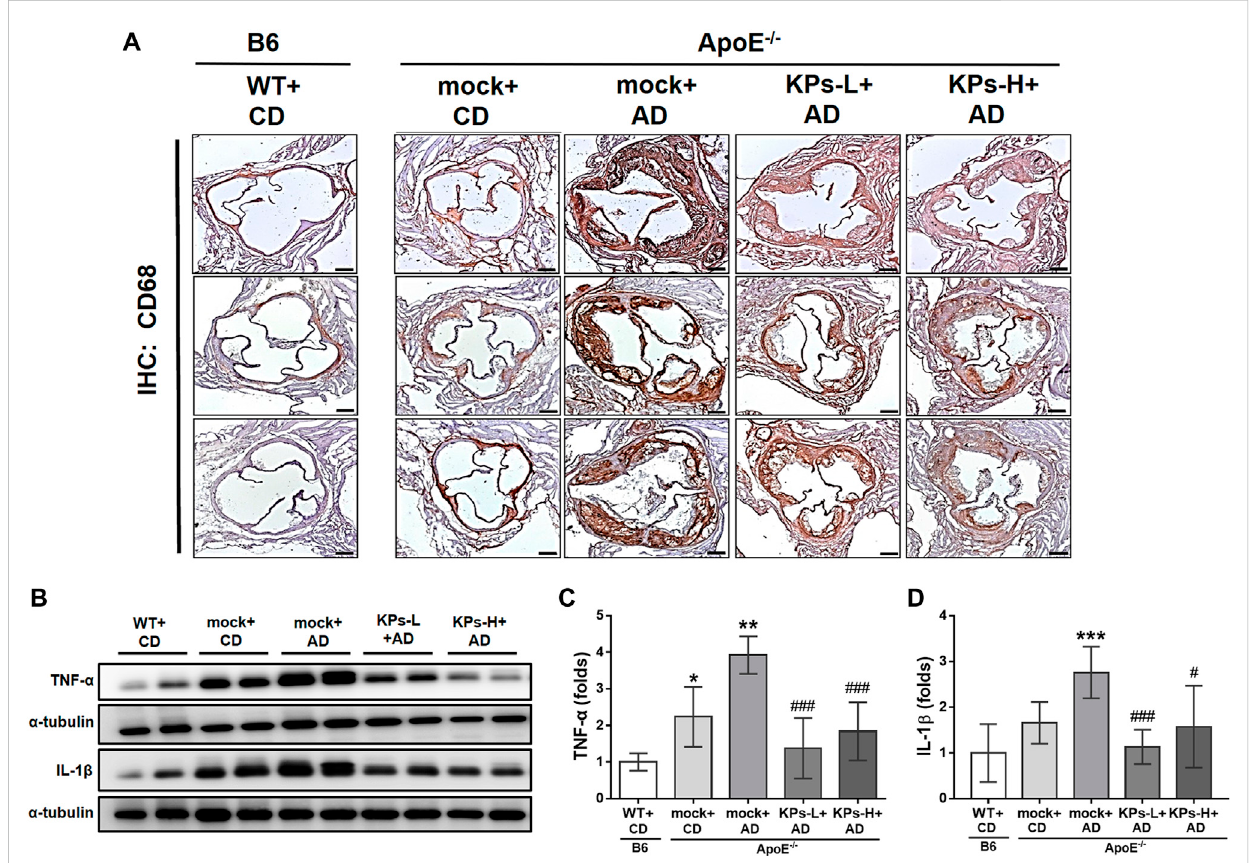
FIGURE 3 KPs attenuate local in fl ammatory responses in aortic roots. (A) Representative images of immunohistochemistry (IHC) staining against the surface marker of macrophages (CD68). Scale bar: 200 μ m. (B) Western blot analysis of TNF- α and IL-1 β expression in aortic root tissue lysates. The relative expression levels of TNF- α and IL-1 β were quanti fi ed by normalizing to α -tubulin, as shown in (C , D) , respectively. Statistical signs (n = 6): * p < 0.05, ** p < 0.01, *** p < 0.001 vs. WT + CD/B6, and # p < 0.05, ### p < 0.001 vs. mock + AD/ ApoE − / −